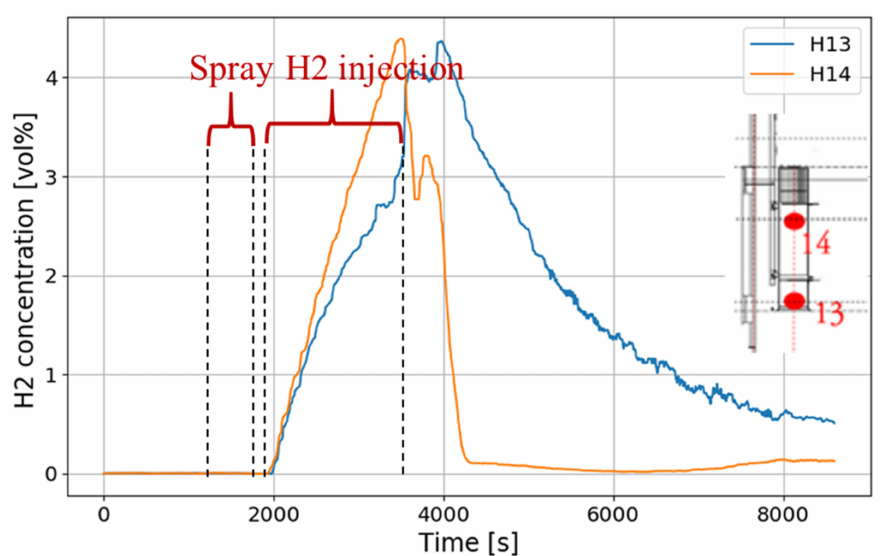
Figure 16. Time variations in the hydrogen concentrations at the PAR inlet and outlet during the SSP3 test. H13: PAR inlet; H14: PAR outlet.